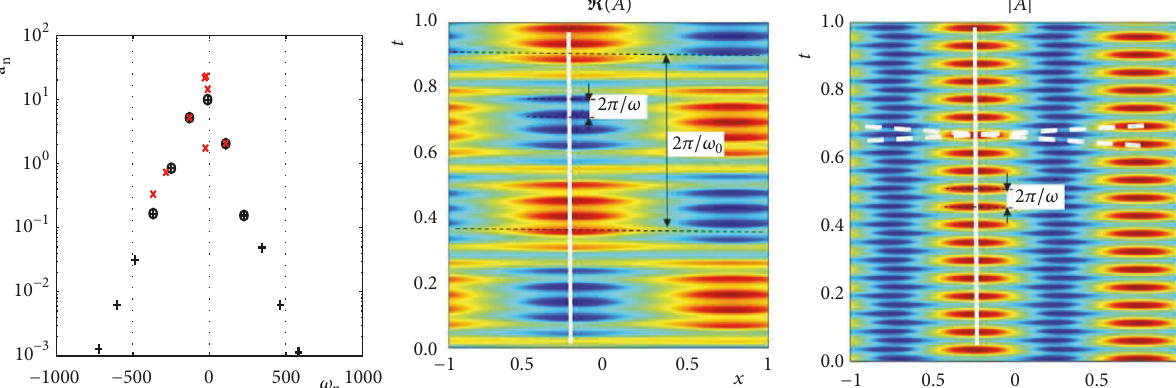
Figure 3: The CGLE for 𝜇 = 20 , plotting the amplitudes versus frequencies in the DMD expansion (left plot) for low (black circles) and high (black crosses) accuracy computations using DMD-50, and using DMD-1 (red symbols), and the color map of R (𝐴) (middle plot) and |𝐴| (right plot).